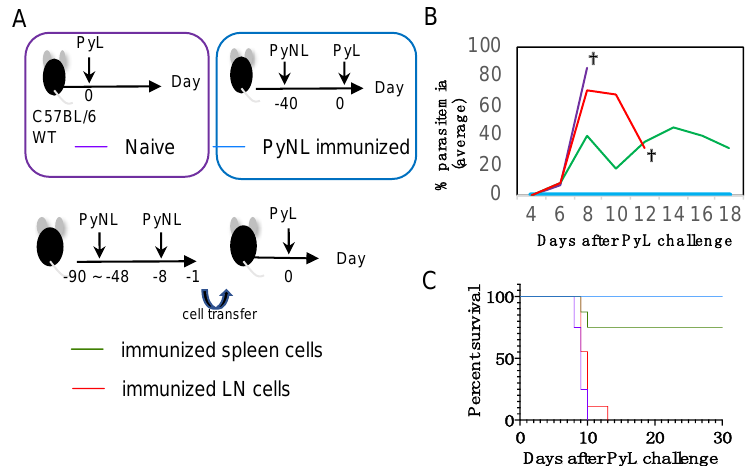
Figure 4. Immunized spleen cells confer protection but immunized peritoneal LN cells did not. ( A ) Experiment protocol. Four groups were challenged with lethal strain PyL at day 0 of the experiment: naïve C57BL/6 mice (upper left: purple line); PyNL immunized mice on day −40 (upper right: blue line); PyNL primed at day −90 to −48, boosted at day − 8 then immunized spleen cells (RBC lysed; 4 × 10 6 cells: green line, 75% of recipient mice controlled the parasitemia) or immunized peritoneal LN cells (4 × 10 6 cells: red line) were transferred to recipient mice on day −1. ( B ) Average parasitemia and ( C ) survival curve (N = 8 in each group from two pooled independent experiments). Dagger indicates death.